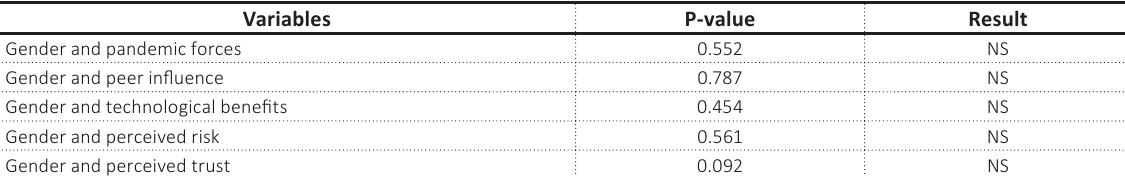
Table 3. Difference between gender and the core variables